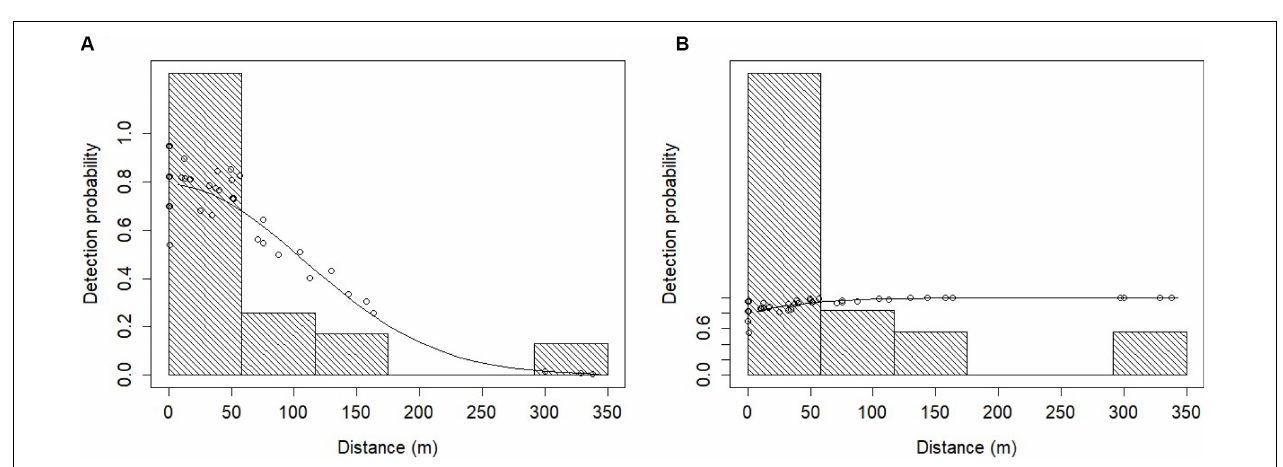
FIGURE 4 | Visual and acoustic platform survey effort as a function of Beaufort sea state.